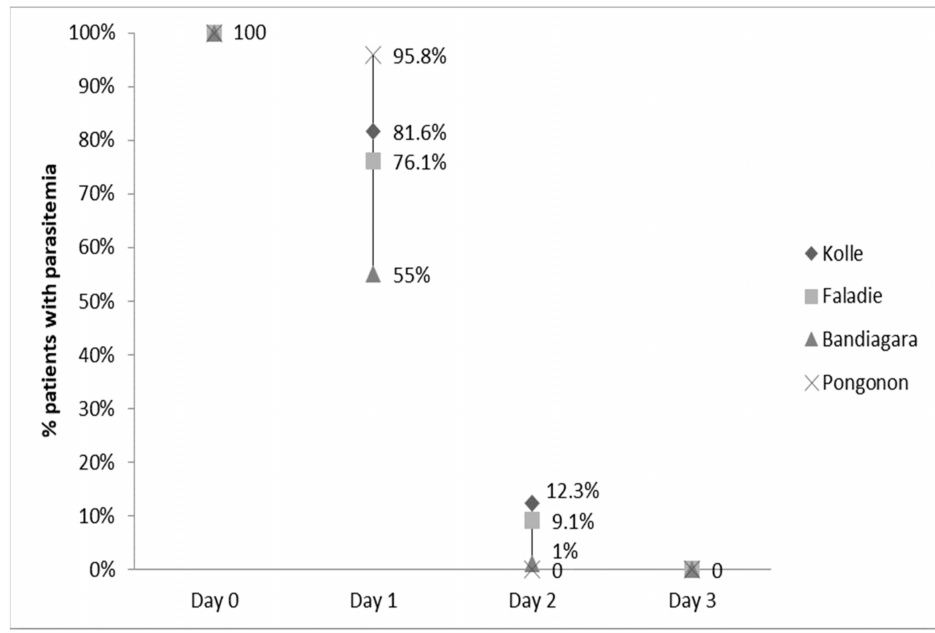
Figure 2. Parasitemia